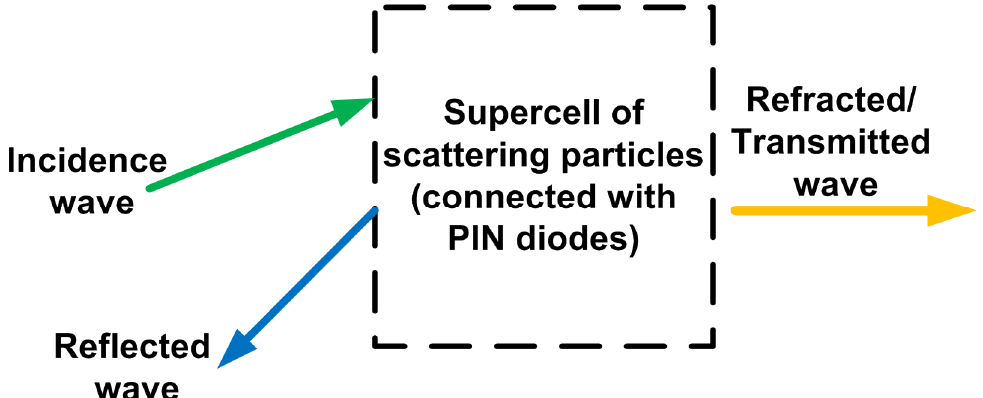
Figure 1. Schematic of RIS system illustrating basic principle [57].